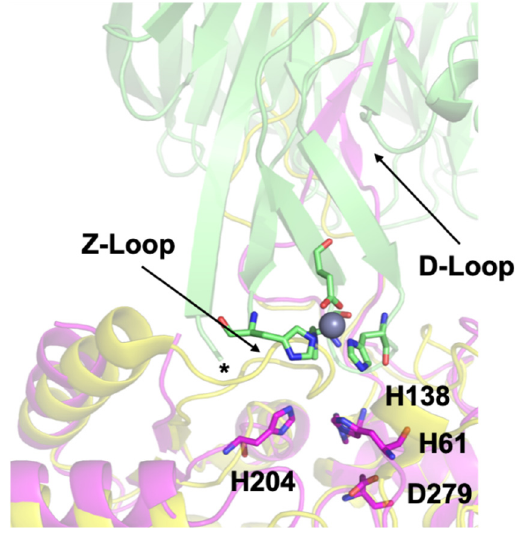
Figure 1. Docking model of the AztC ‐ AztD transfer complex. AztD is shown in green with zinc binding residues shown as sticks colored according to element and zinc as a gray sphere. The first modeled N ‐ terminal residue of AztD (His 28) is indicated by an asterisk. Apo AztC is shown in magenta with zinc binding residues labeled and shown as sticks colored according to element. Holo AztC superimposed on the apo form is shown in yellow, illustrating how the position of the Z ‐ loop in this structure would block zinc transfer.